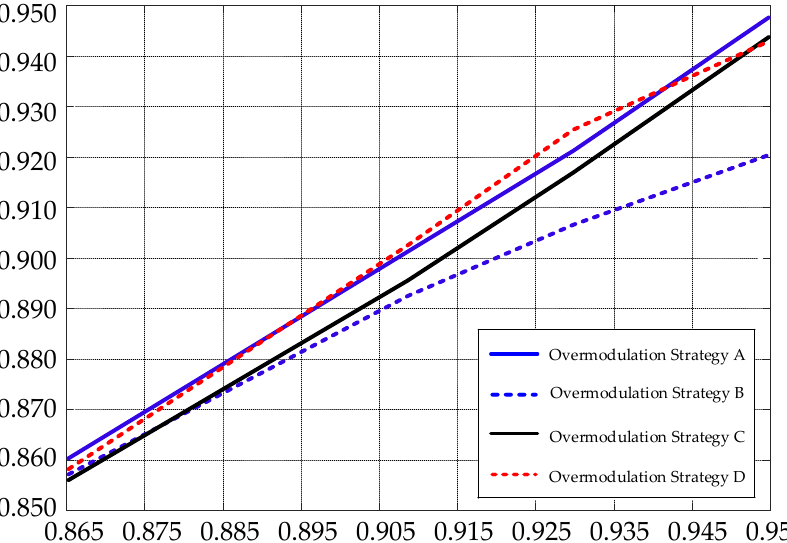
Figure 10. Two ‐ level converter test system: ( a ) system block diagram; ( b ) testing platform.